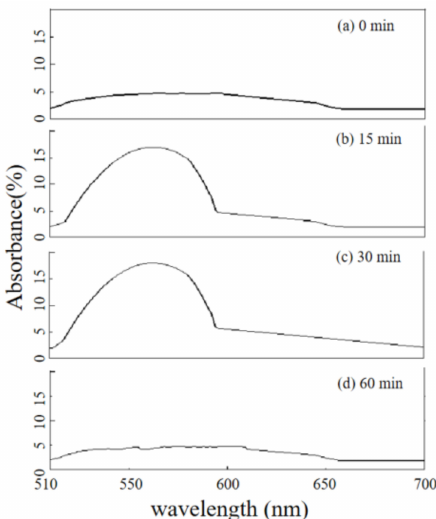
Figure 12. Absorption spectra of the solution of BCA and MO recorded every 15 min to determine Cu (I) ions. ( a ) 0 min, ( b ) 15 min, ( c ) 30 min, and ( d ) 60